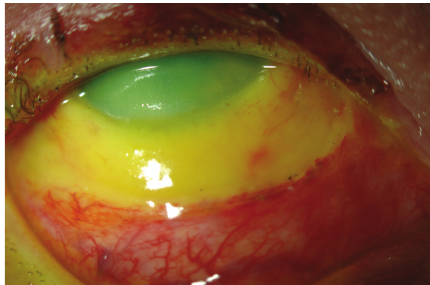
Figure 2: Patient with grade IV ocular surface burn. Note severe ischemia extending 4mm from the cornea and corneal haze. Patient required multiple reconstructive procedures including combined conjunctival-limbal autograft and keratolimbal allograft.